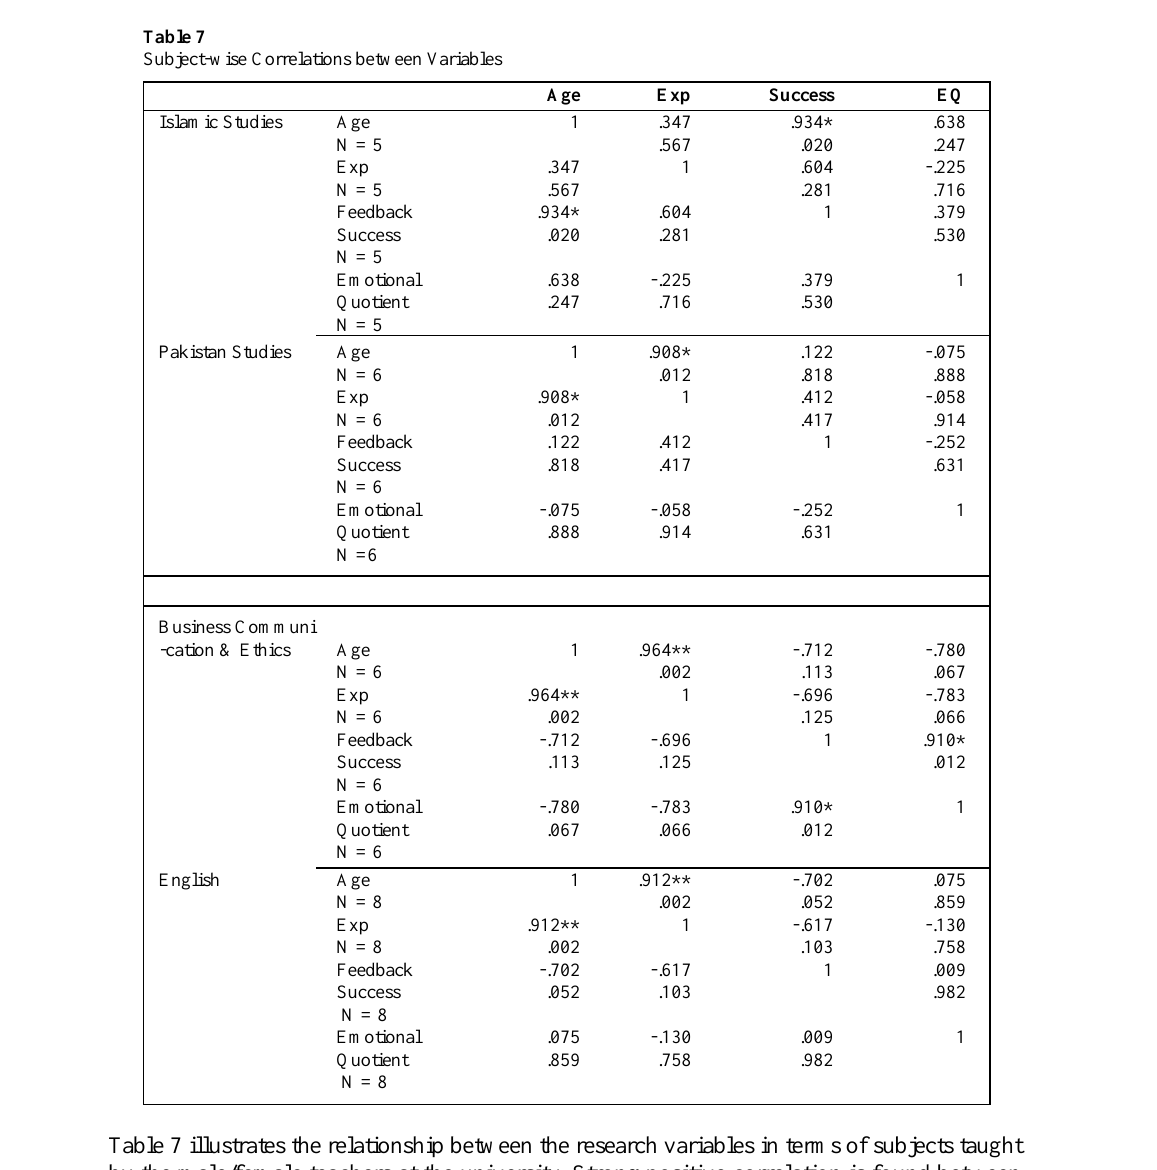
Table 7 Subject-wise Correlations between